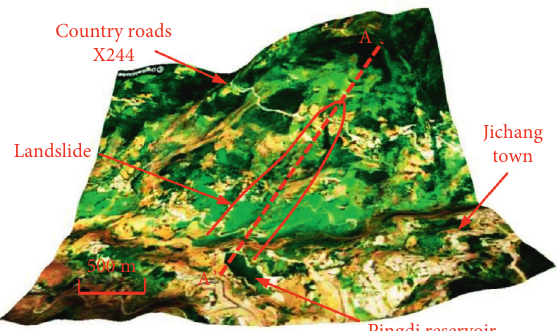
Figure 3: 3D satellite image of the Jichang slope.